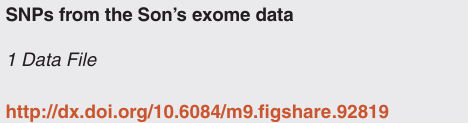
23andMe SNPs for which SNPedia annotations are